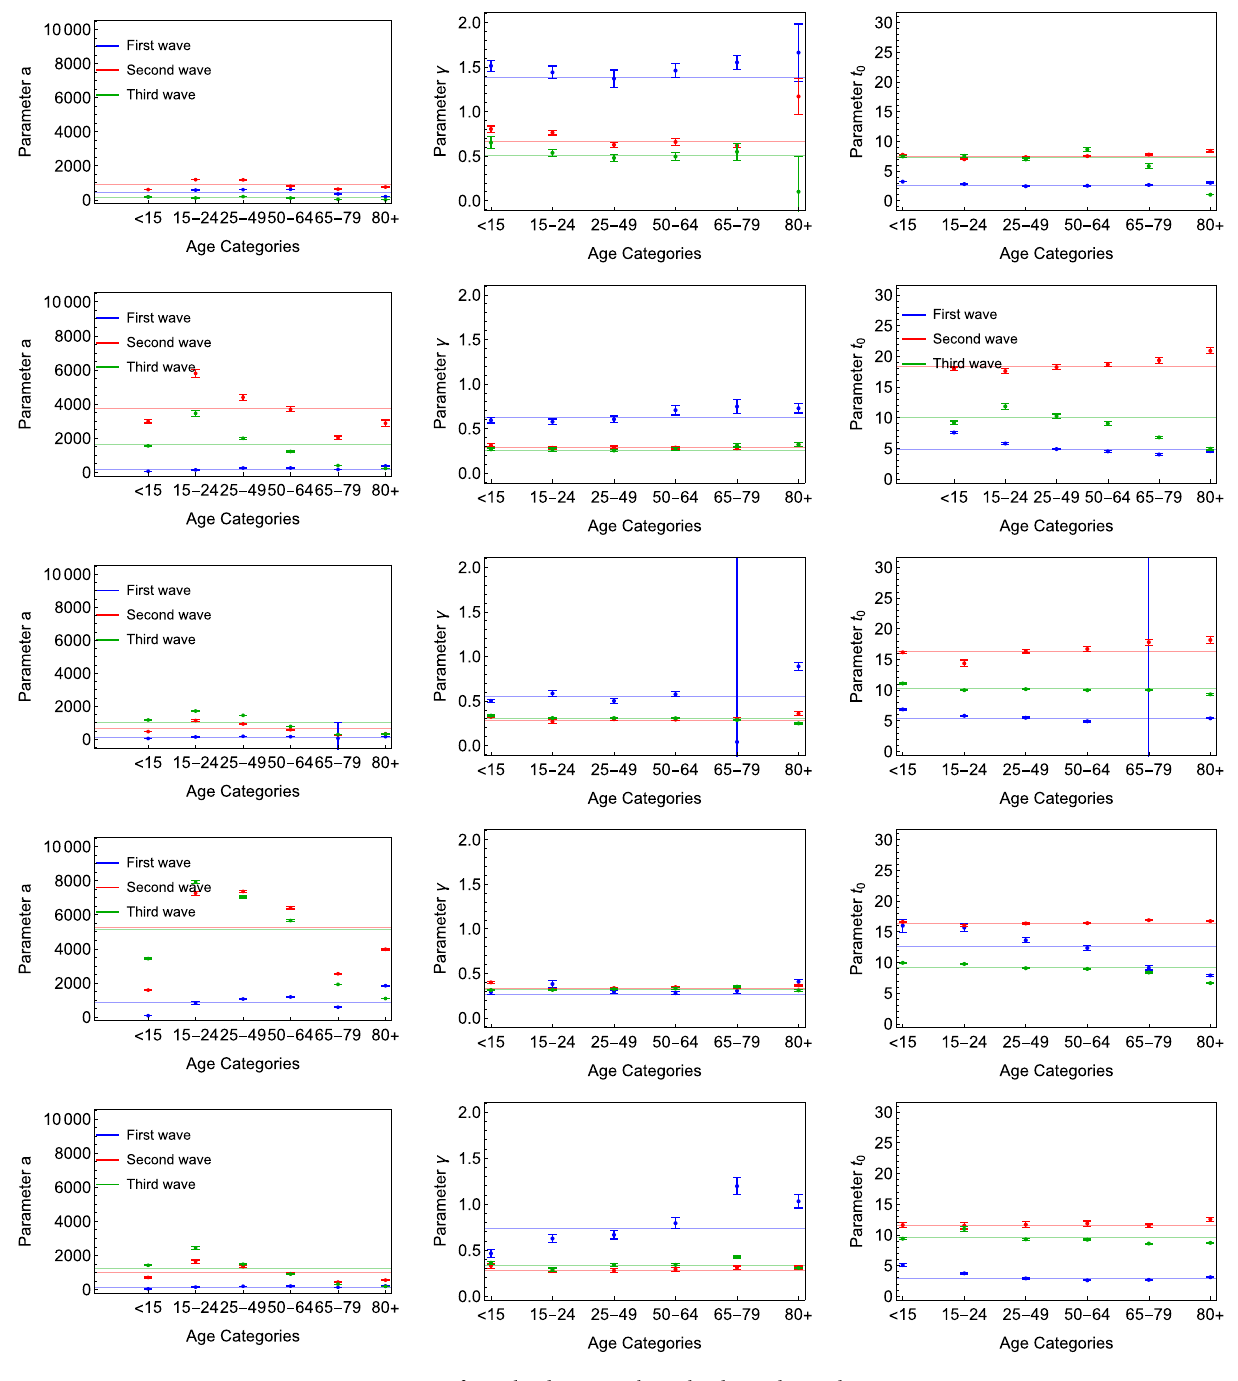
Figure 9. Fit parameters for Iceland, Denmark, Finland, Sweden and